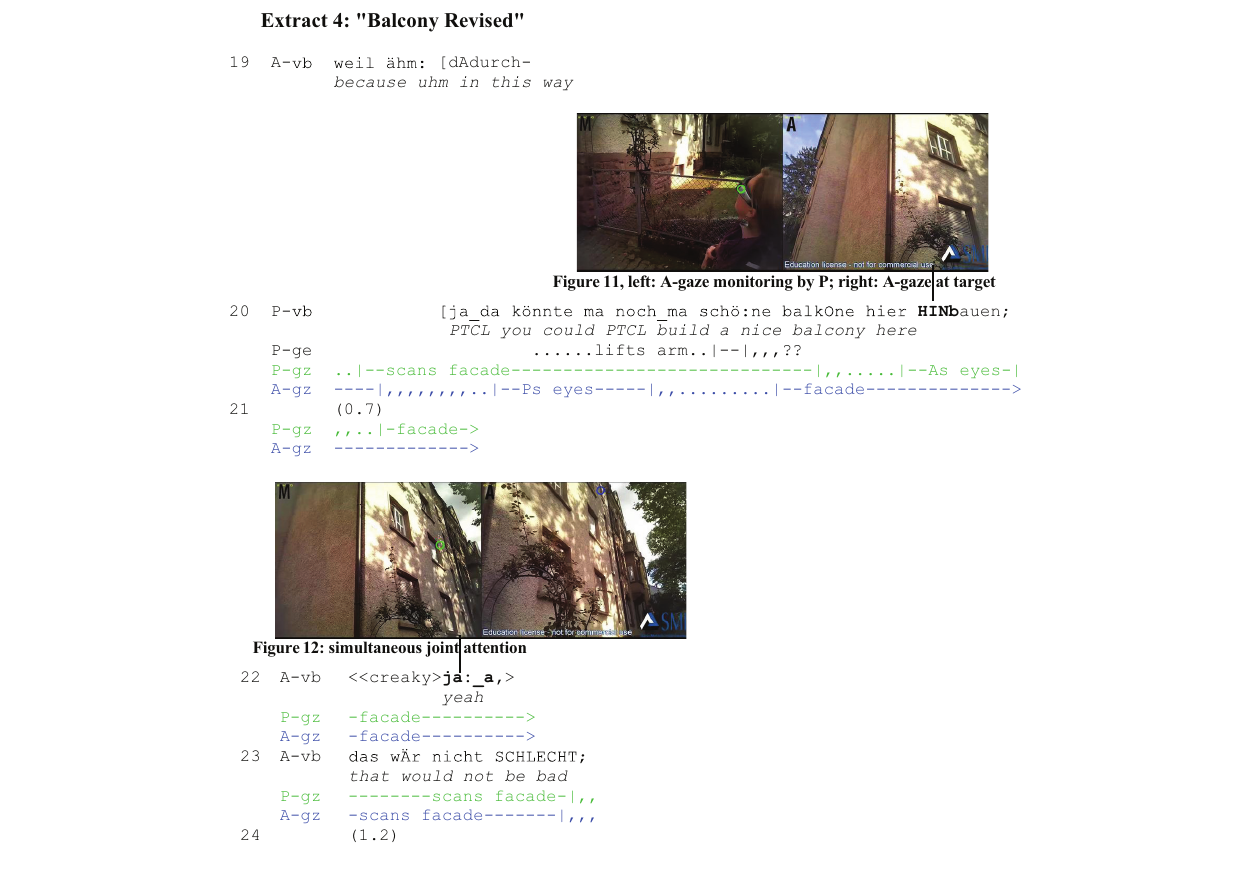
Figure 11, left: A-gaze monitoring by P; right: A-gaze at target